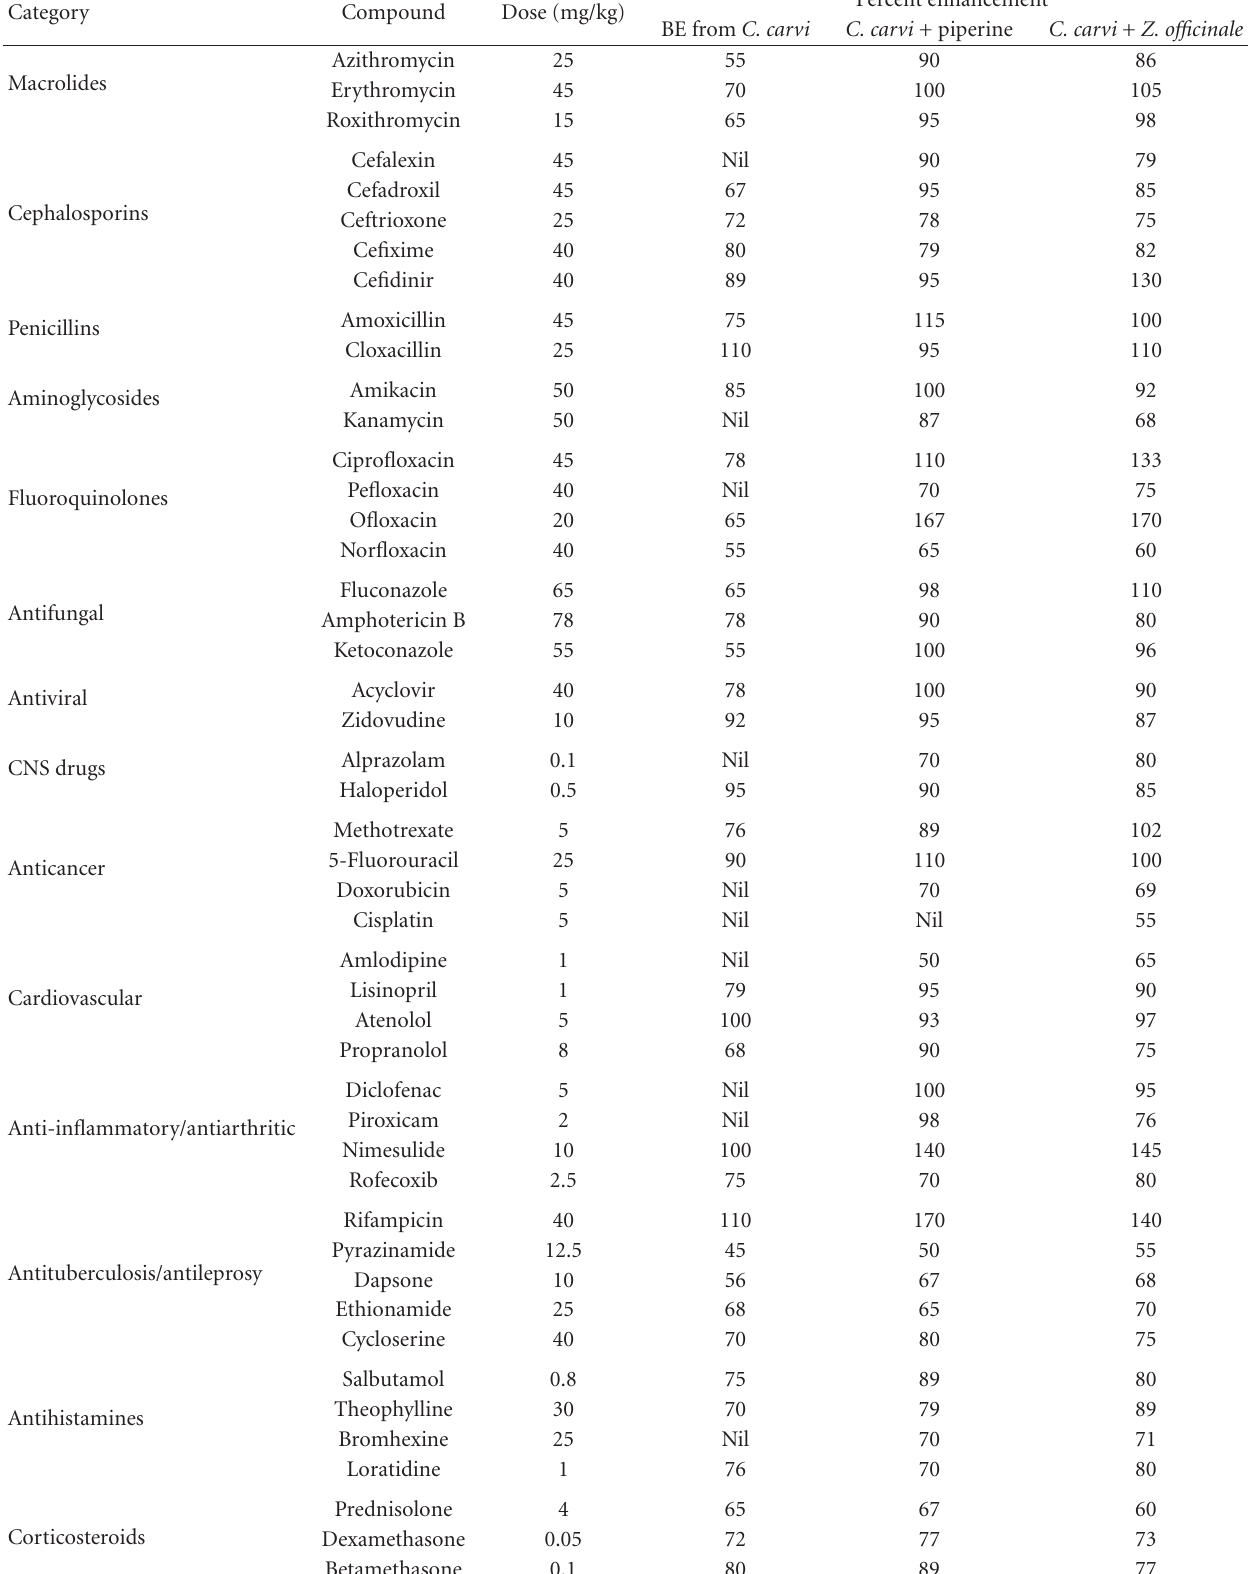
Table 24: Percent enhancement in bioavailability of di ff erent drugs/compounds by supplementation of bioactive fractions from C. carvi and its combination with piperine and Z. o ffi cinale [5,